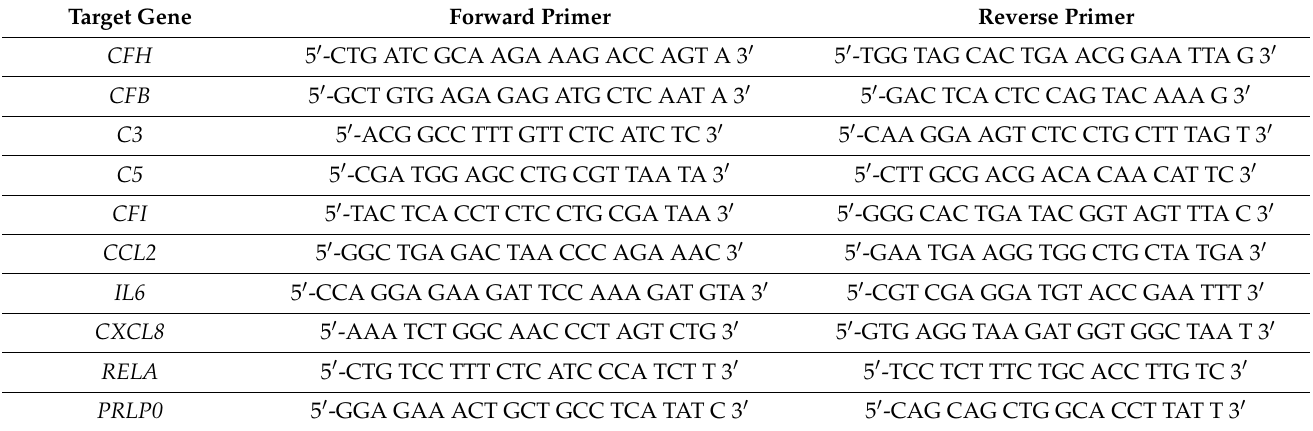
Table 1. List of primers used in this study.